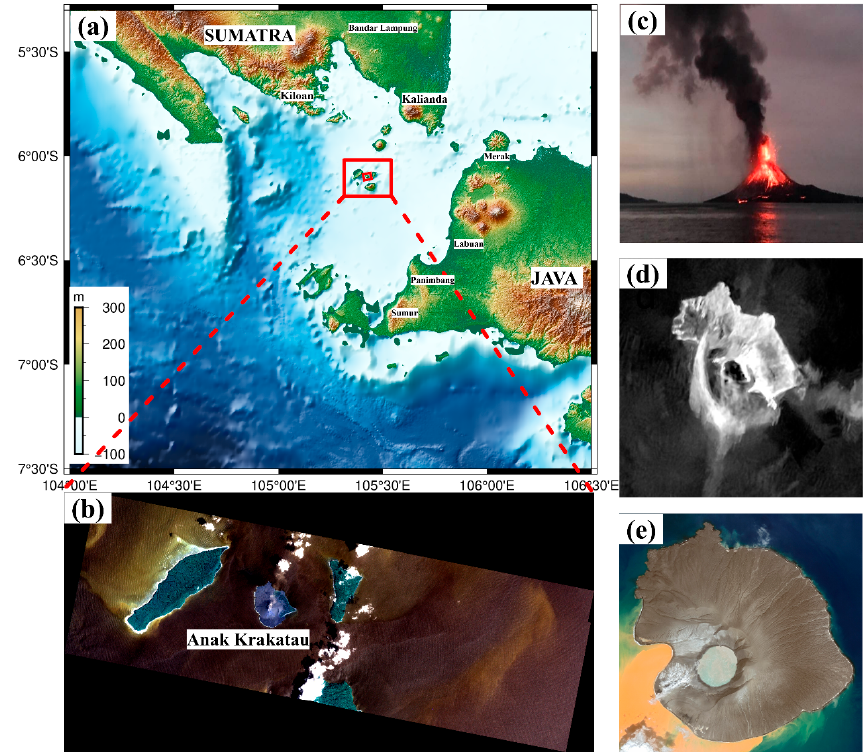
Figure 1. Location map and images of Anak Krakatau volcano. ( a ) Location map; ( b ) volcano before the eruption (Planet image); ( c ) a photo of the volcano eruption (from online source [21]); ( d ) volcano after eruption (synthetic aperture radar (SAR) image); ( e ) volcano after eruption (Google image).